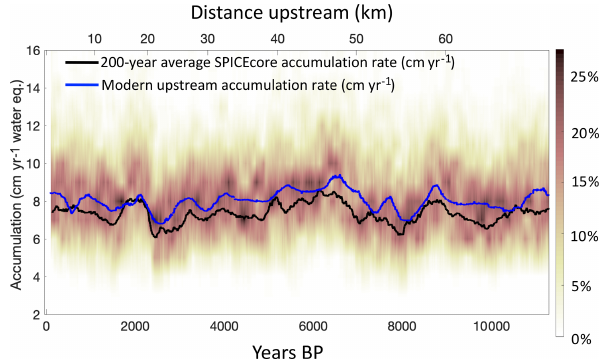
Figure 10. The Holocene accumulation rate history in SPICEcore. Shading indicates a running histogram of accumulation rate with darker colors indicative of more years at a given accumulation rate. The color axis (right) indicates percentage of years with a given accumulation rate within 1cm accumulation bins across 200-year sliding intervals. The solid black line is the 200-year running mean of accumulation rate. These data are compared with modern spa- tial accumulation rates upstream of SPICEcore (blue; upper x axis; Lilien et al., 2018).